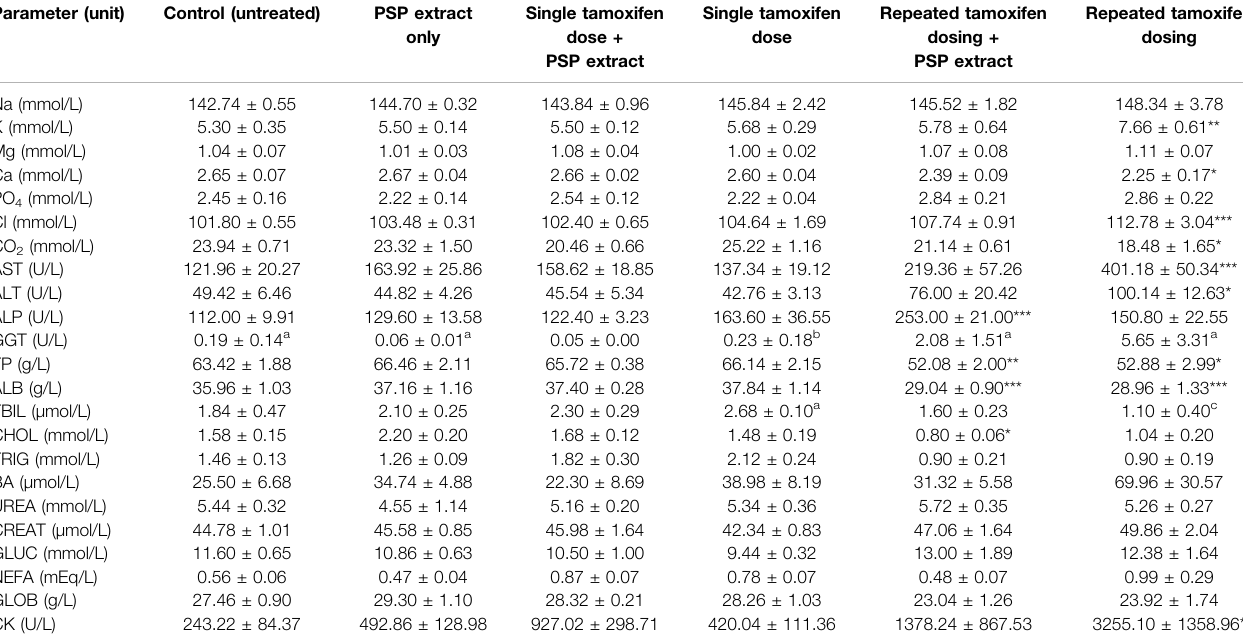
TABLE 3| Biochemicalparametersofsingle (20 mg/kg) and repeated tamoxifen oral doses(20 mg/kg per day over 12 days) with/withoutPSPextract (340 mg/kgorallyfor 7 days) in female Sprague Dawley rat serum. Parameter (unit)